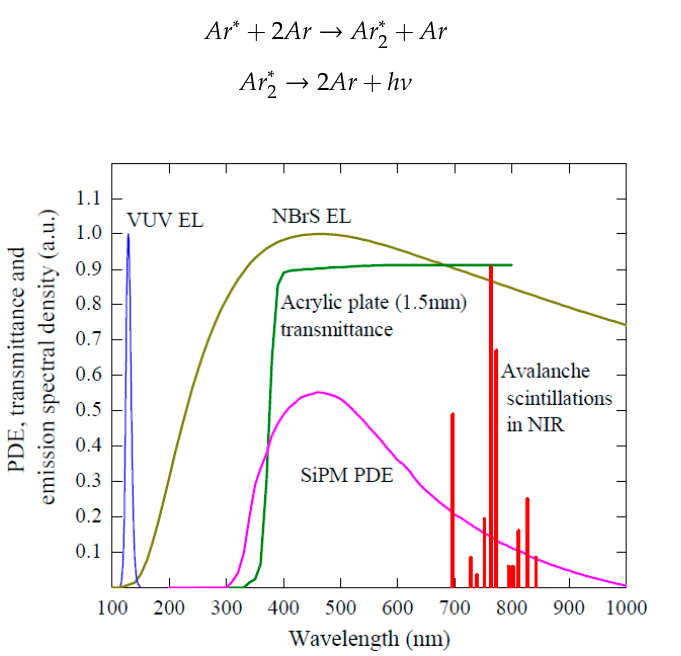
Figure 4. Photon emission spectra in gaseous Ar due to ordinary scintillations in the VUV measured in [8], NBrS EL at 8.3 Td theoretically calculated in [9] and avalanche scintillations in the near infrared (NIR) measured in [10,11]. Also shown are the photon detection efficiency (PDE) of SiPM (MPPC 13360-6050PE (Hamamatsu)) at overvoltage of 5.6 V and the transmittance of the acrylic plate (1.5 mm thick) [12].